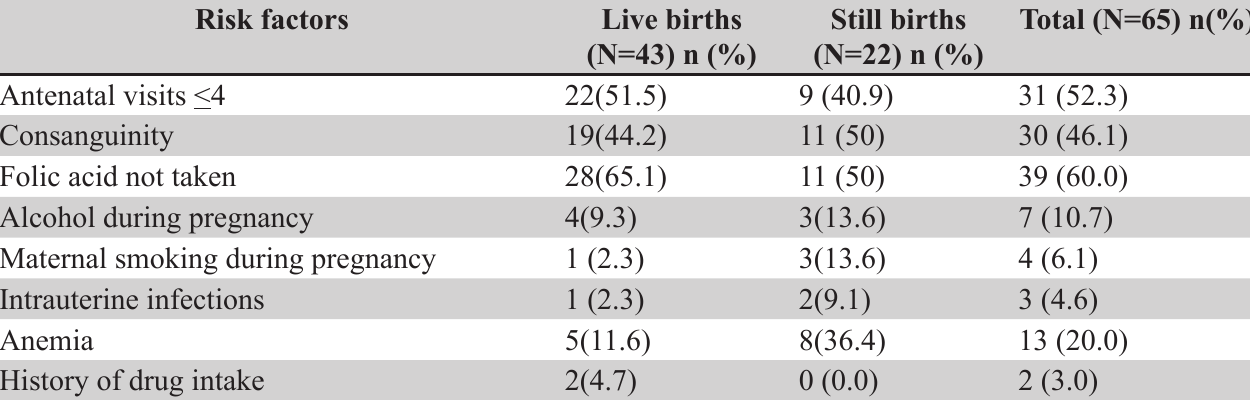
Table 2. Antenatal risk factors in birth defect